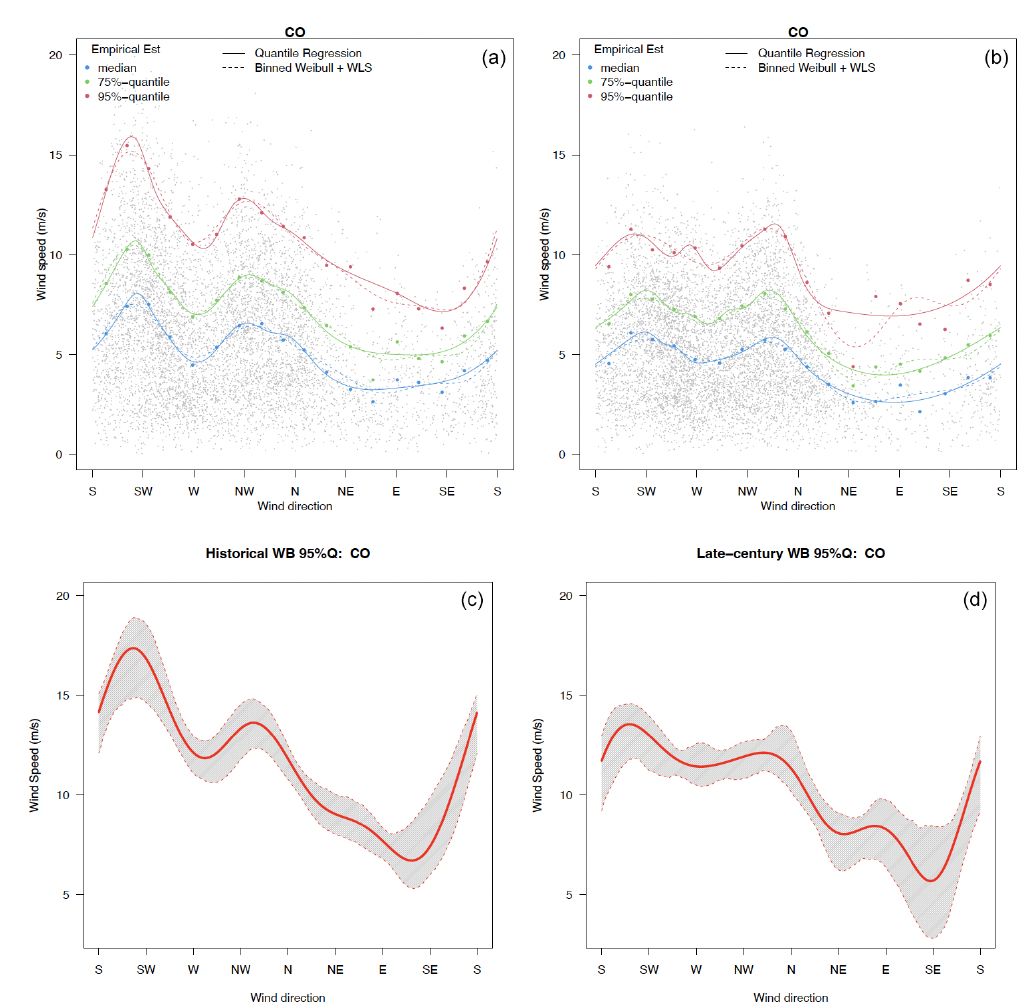
Figure 8. Estimated wind speed quantiles ( a, b ; blue for the 50th, green for the 75th, and red for the 95th quantile) conditioned on wind direction and their bootstrapping estimation uncertainties ( c, d ; only results for the 95th quantile are shown) at the Colorado Mountains grid cell for the winter season under the historical (a, c) and late century periods (b, d)